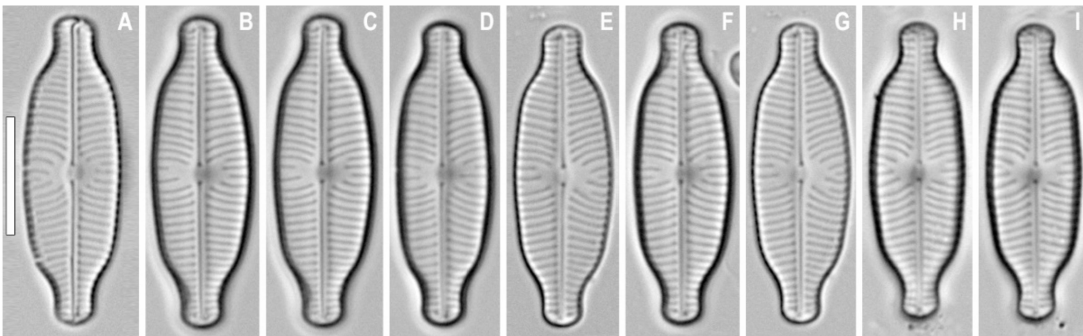
Figure 6. Placoneis subundulata Kezlya, Glushchenko, Kulikovskiy & Kociolek sp. nov. Strain VN1199, slide no. 01682. ( A – I ) Light microscopy, differential interference contrast, size diminution series. ( G ) Holotype. Scale bar = 10 µ